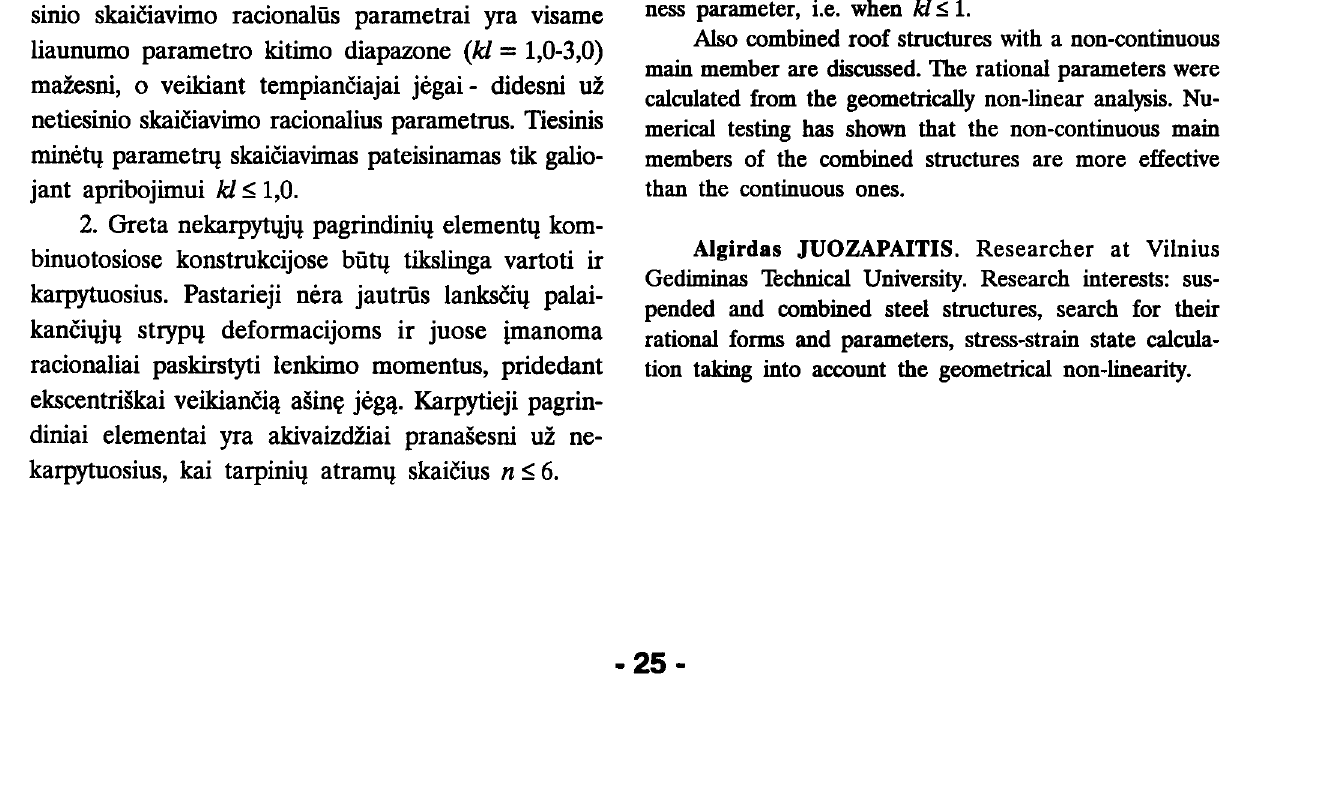
s_ 18vados 1. K.ombinuotvjq konstrukcijq pagrindinius